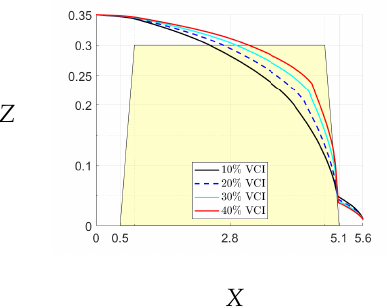
Figure 18. The influence of the fouling ratio on the railway ballast (Model 2) when the layer 1 has different percentages of VCI where h 2 =